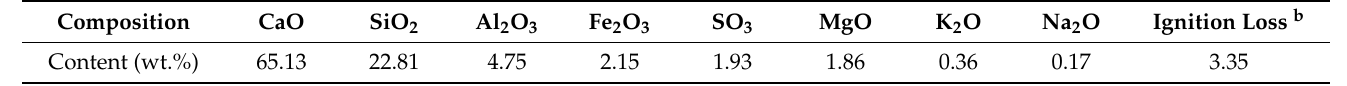
Table 2. The total chemical composition of cement a .